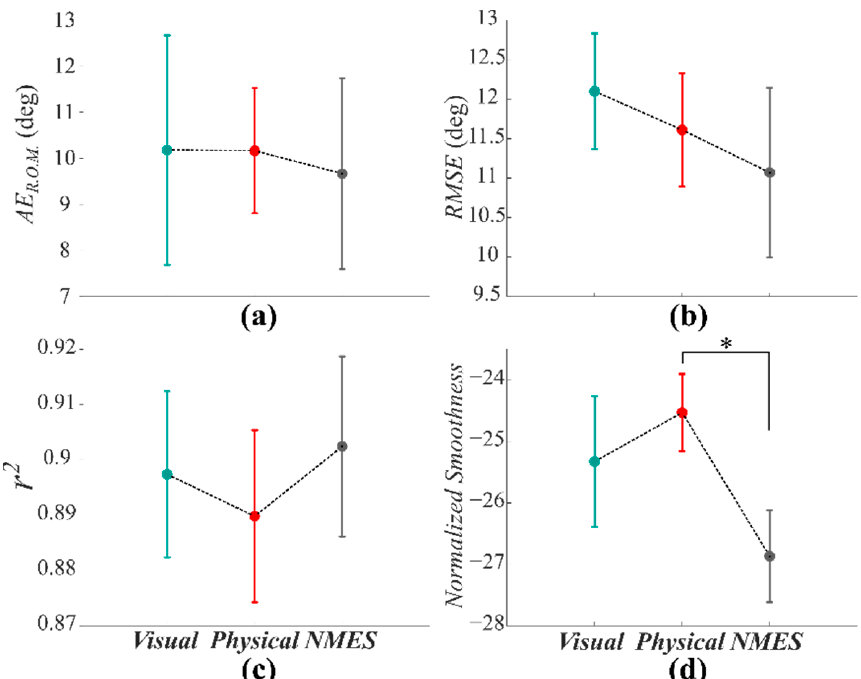
Figure 5. Kinematic parameters were computed among subjects for the three feedback conditions ( Visual , Physical , and NMES ). ( a ) the AE R.O.M. , ( b ) the RMSE , ( c ) the r 2 , and ( d ) the Normalized Smoothness . Significant differences ( p < 0.0025) are marked with an asterisk.